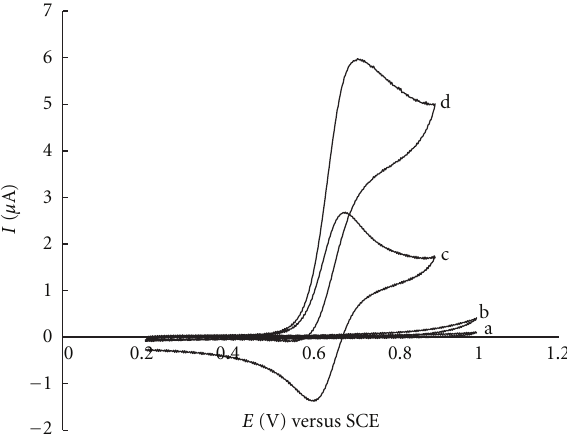
Figure 2: Cyclic voltammograms of a: phosphate bu ff er solution (pH 4.0, 0.05M), b: a + 0.5 mM CAP, c: a + 0.5 mM CPZ, and d: c + 0.5mM CAP. Scan rate 50 mVs − 1 at the